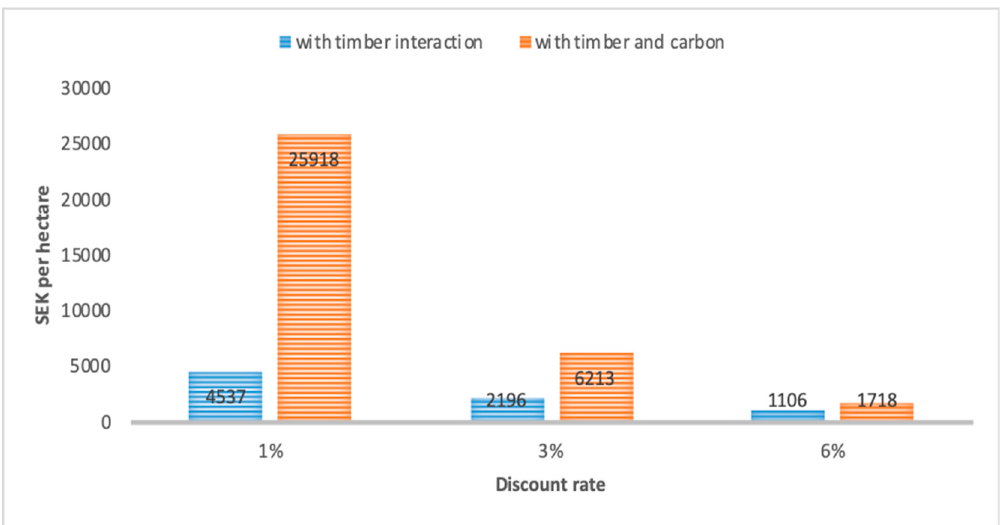
Figure B2. Value of site quality for different discount rates. Figure A2. Value of site quality for di ff erent discount